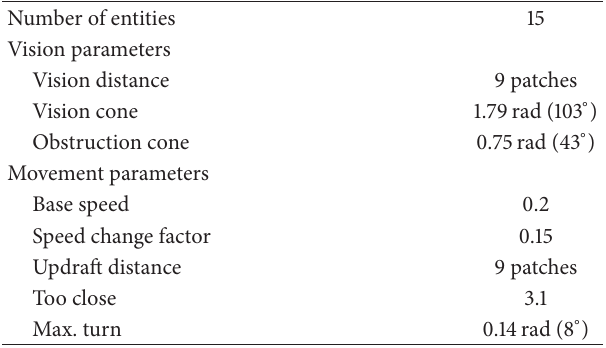
Table 2: Parameters to generate V-formations in NetLogo using Nathan’s